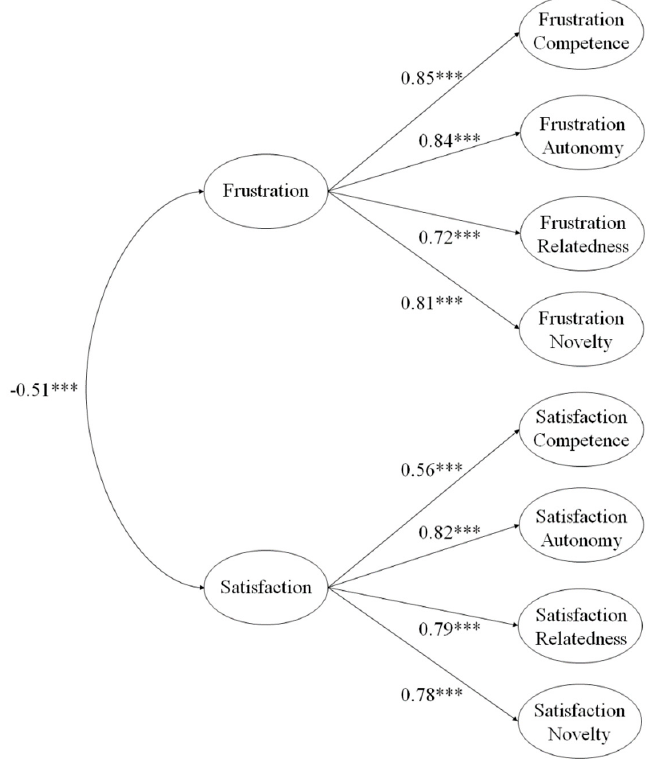
Figure 2. Higher order confirmatory factor analysis of the BPNS.